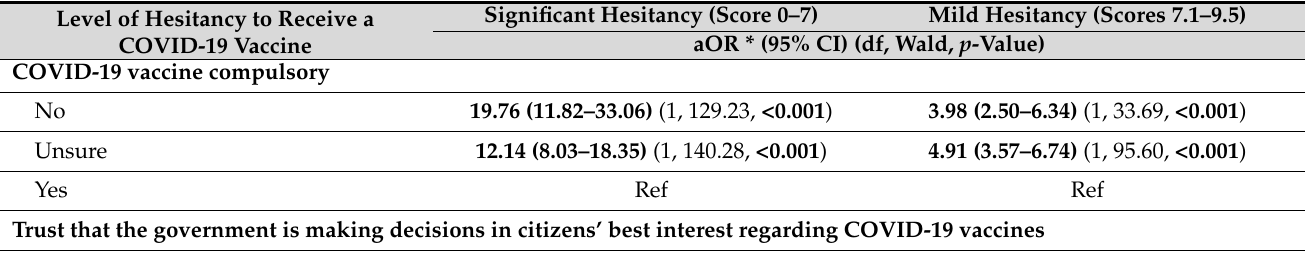
Table 3. Cont. Significant Hesitancy (Score